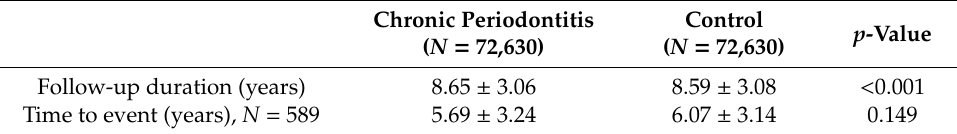
Table 4. Track time of chronic periodontitis and control